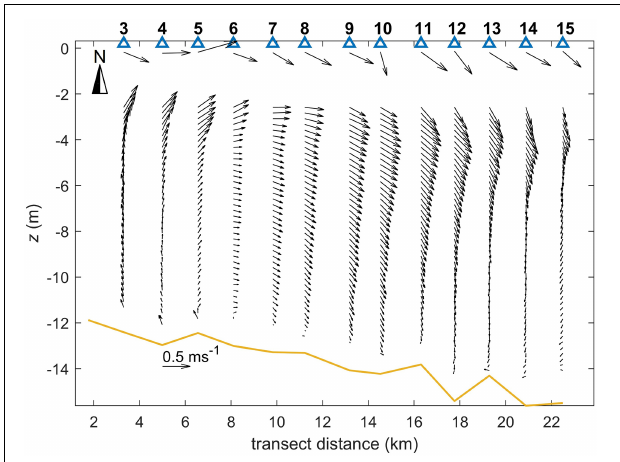
FIGURE 8 | Combined drone-ADCP vertical profiles of horizontal velocity vectors, stations 3–15. Heavy line is the bottom.